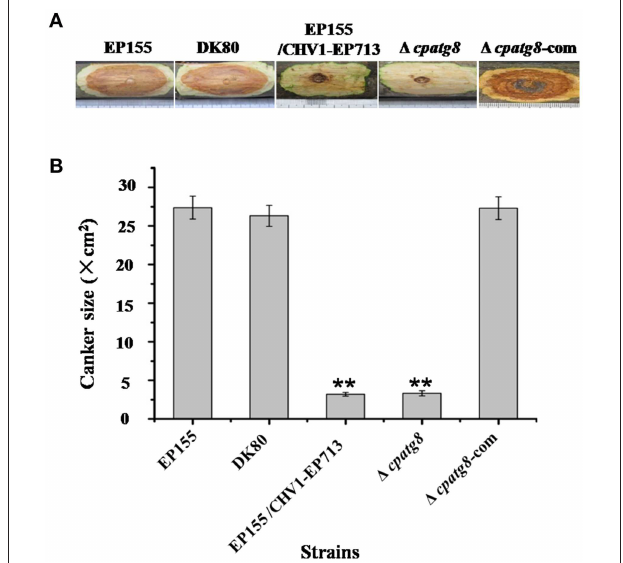
FIGURE 5 | Electron micrographs of the hyphae of strain DK80 and 1 cpatg8 mutant. (A) Autophagy in the aerial hyphae of C. parasitica . Autophagic bodies in the vacuoles of the aerial hyphae of the strain DK80 and 1 cpatg8 mutant grown on plates of PDA were examined using differential interference microscopy. (B) Autophagy was blocked in 1 cpatg8 mutant. Vacuoles in the hyphae of the parental strain DK80 and 1 cpatg8 mutant were observed using an electron microscope after being cultured in EP liquid media in the presence of 2mM PMSF for 4h (bar, 0.5 µ m). (C) The quantification of the number of autophagic bodies. Arrow indicates autophagic body (bar, 5 µ m). Values are means ± S.E.M of three independent experiments. ** indicates P < 0.01, determined by Student’s t -test.